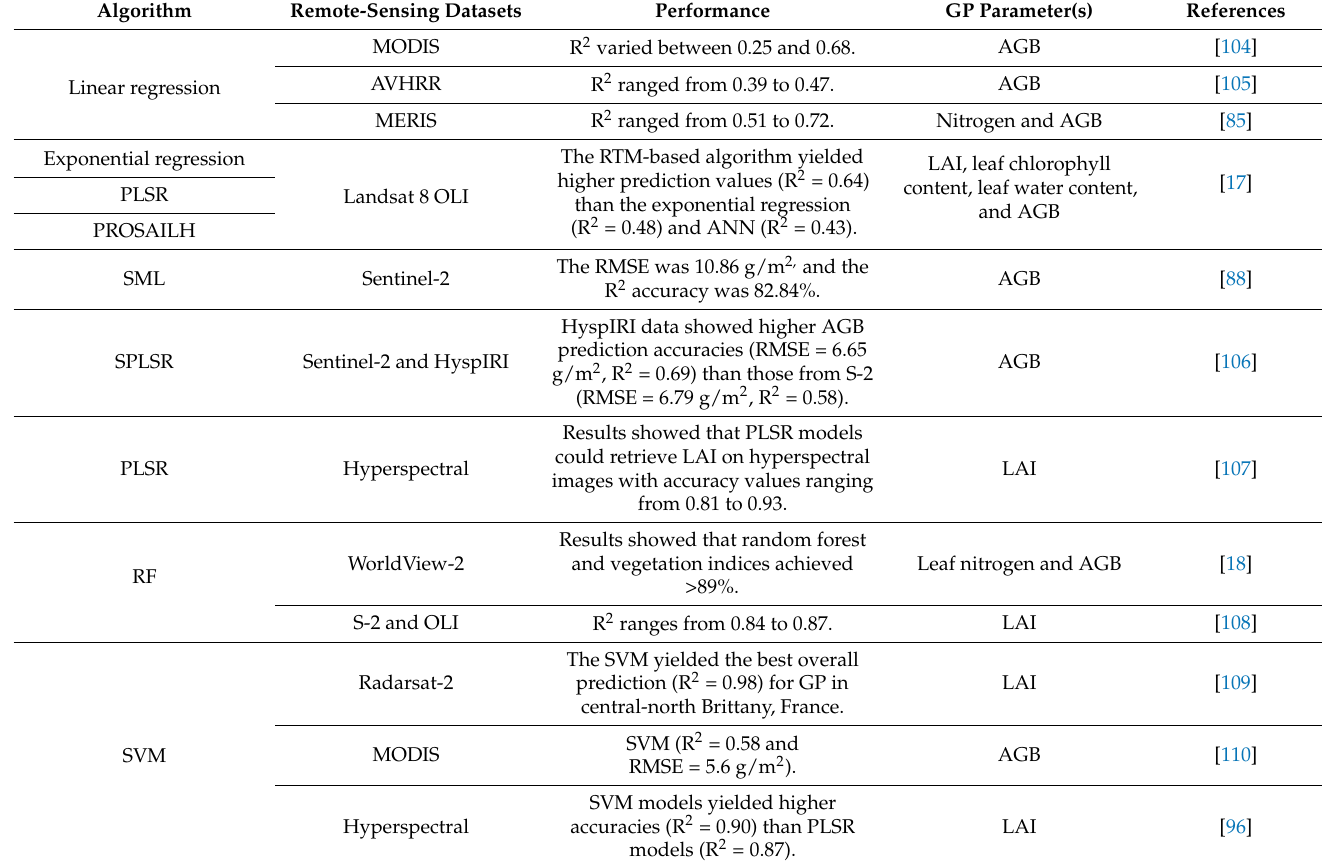
Table 3. Available algorithms for grass productivity prediction using remotely sensed